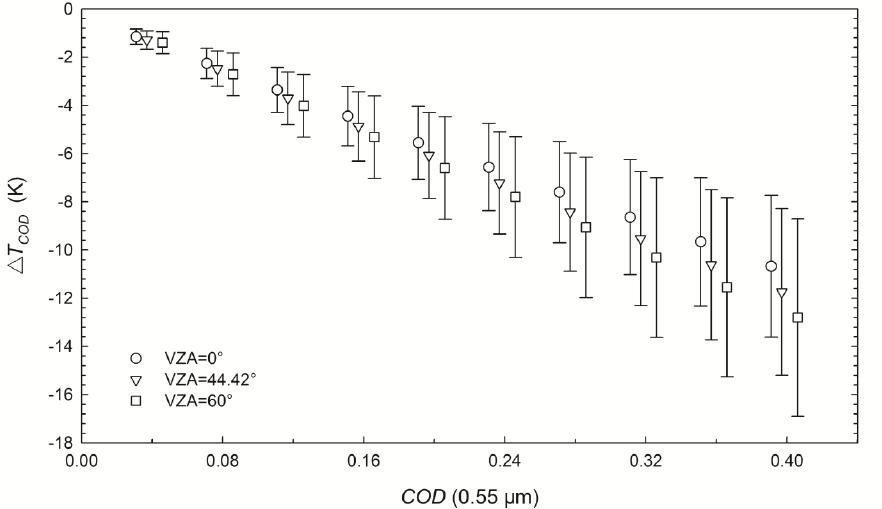
Figure 2. Influence of cirrus clouds on LST retrieval (  T COD ) using the GSW algorithm with simulated MODIS data for three VZAs. The hollow symbols indicate the biases and the half-length of vertical bars represent the STDs of  T COD calculated with Equation